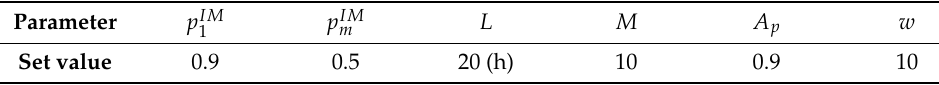
Table 2. Joint optimization model parameter initial setting.